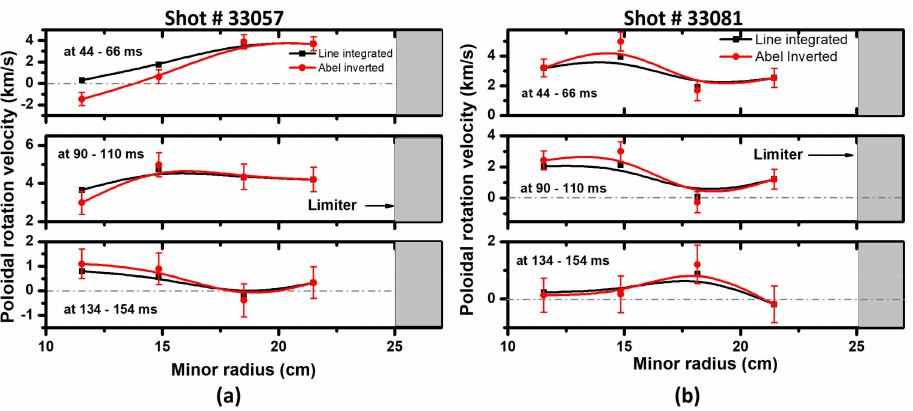
Figure 6. Radial profile of the carbon ion poloidal rotation velocity (km / s) along with the error bars for